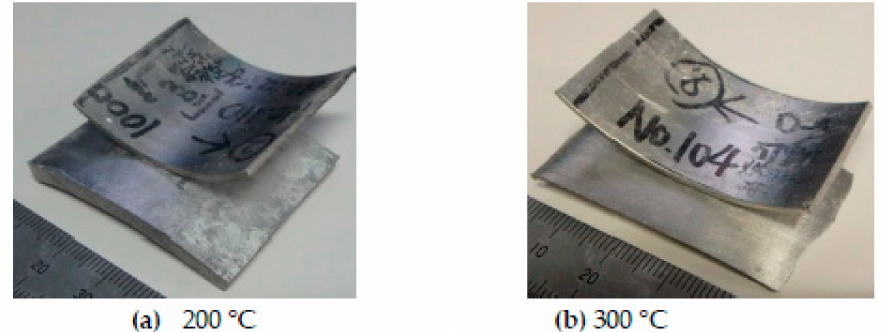
Figure 5. Peeling of the overlay strip from the base strip. Base strip temperature: ( a ) 200 ◦ C, ( b ) 300 ◦ C.